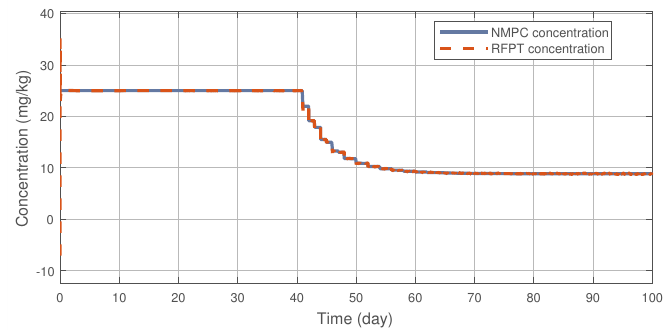
Figure 4. Administration protocols of the RFPT and the NMPC controller.